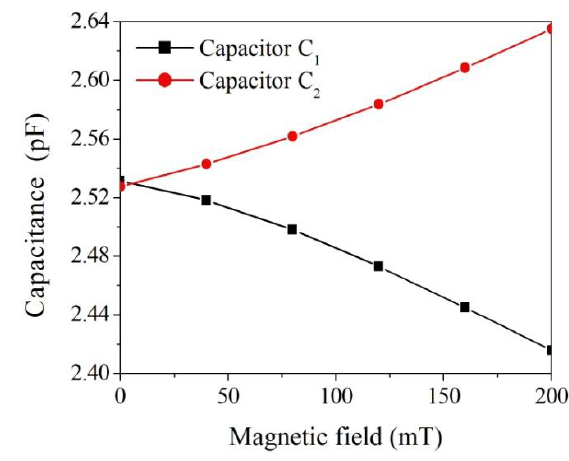
Figure 5. Simulation of capacitance variation in the magnetic